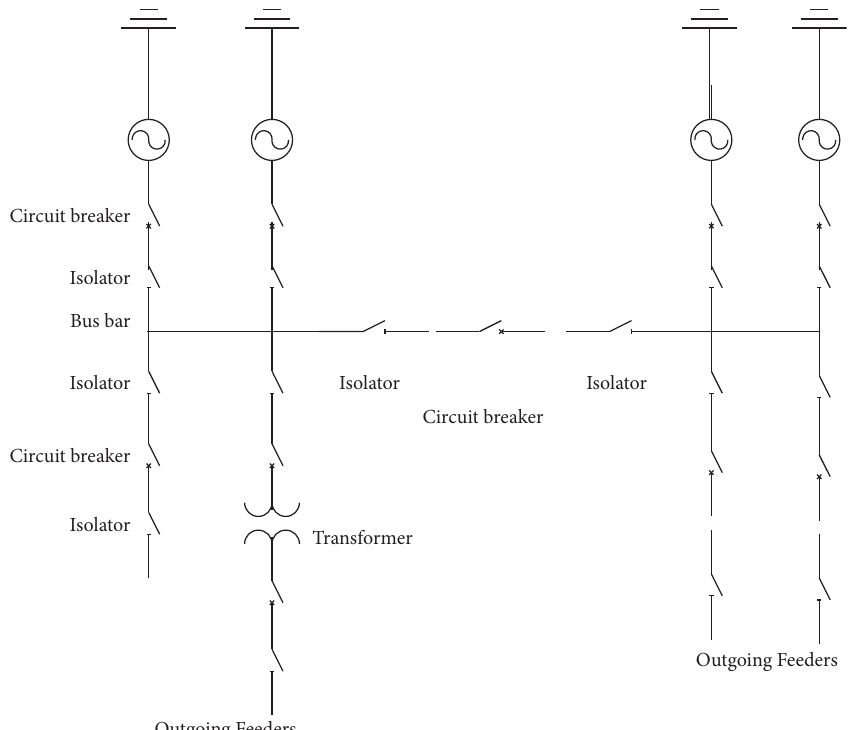
Figure 1: Single busbar arrangement with bus sectionalized.